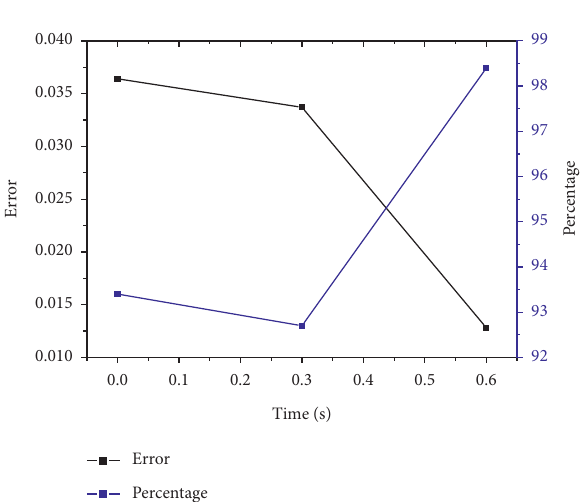
Figure 5: Comparison of the alignment accuracy of the central region of the face under different